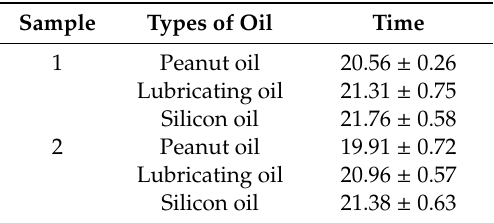
Table 3. The times taken for the composite sponge samples to adsorb di ff erent types of oil to reach full